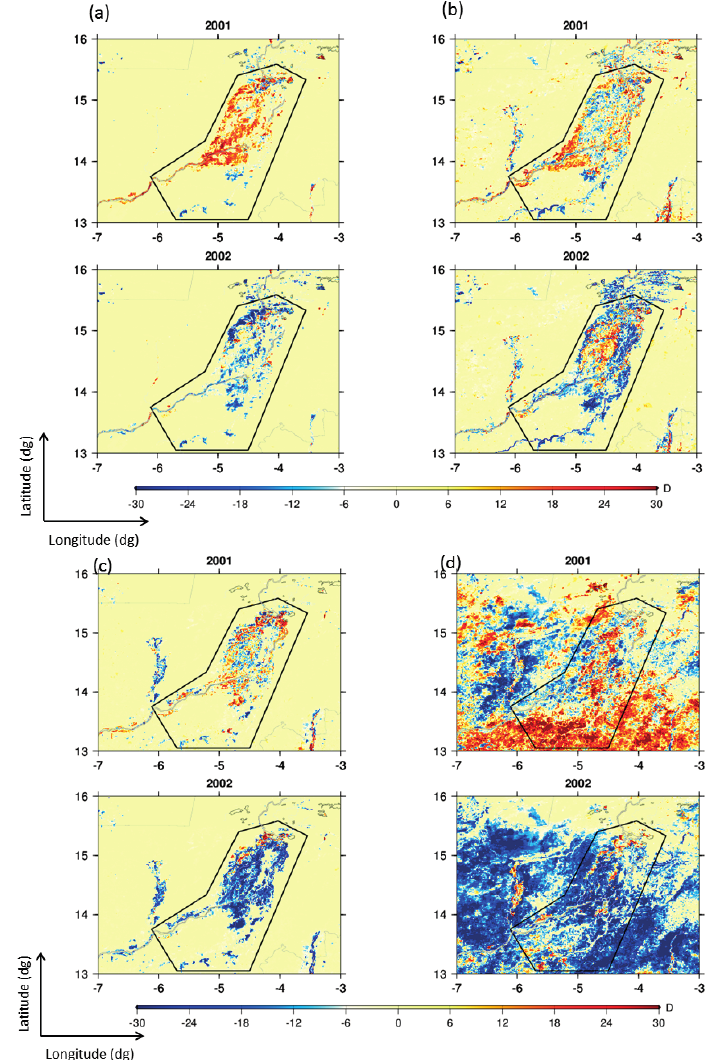
Figure 8. Yearly anomalies of duration (in day) of presence of ( a ) open water and ( b ) mixture of water and dry land; ( c ) aquatic vegetation; and ( d ) vegetation for 2001 and